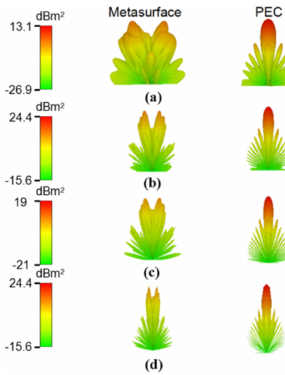
Figure 7. The simulation of the bistatic RCS reduction for the metasurface, under di ff erent incident angles, including 0 ◦ , 15 ◦ , 30 ◦ , and 45 ◦ , in ( a ) TE wave and ( b ) TM wave.